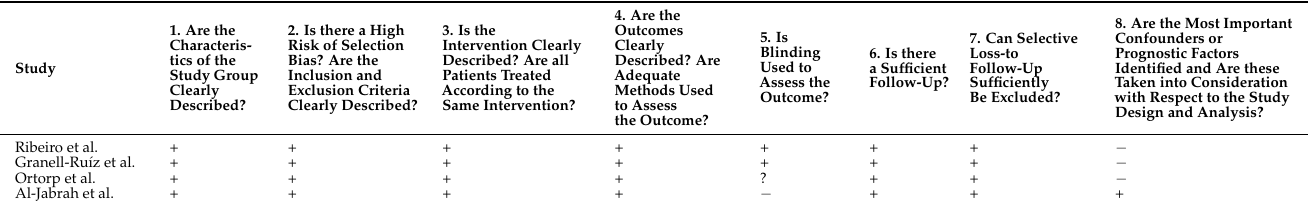
Table 3. Quality of included studies using a tool developed by den Hartog et al., focusing on eight items. Studies scoring five or more plus signs were considered